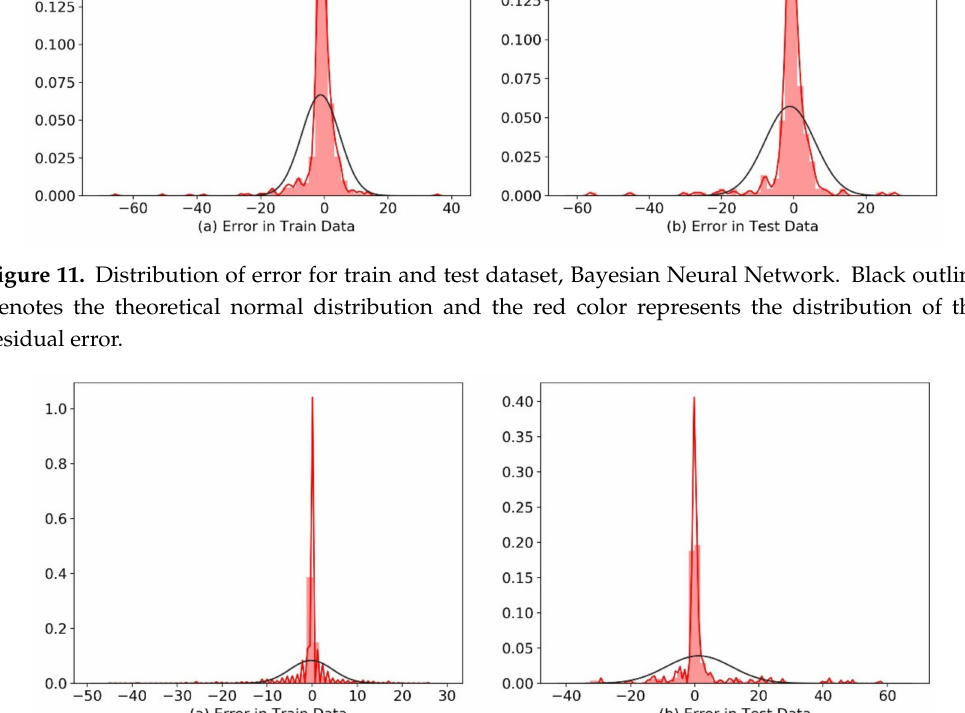
Figure 12. Distribution of error for train and test dataset, Random Forest. Black outline denotes the theoretical normal distribution and the red color represents the distribution of the residual